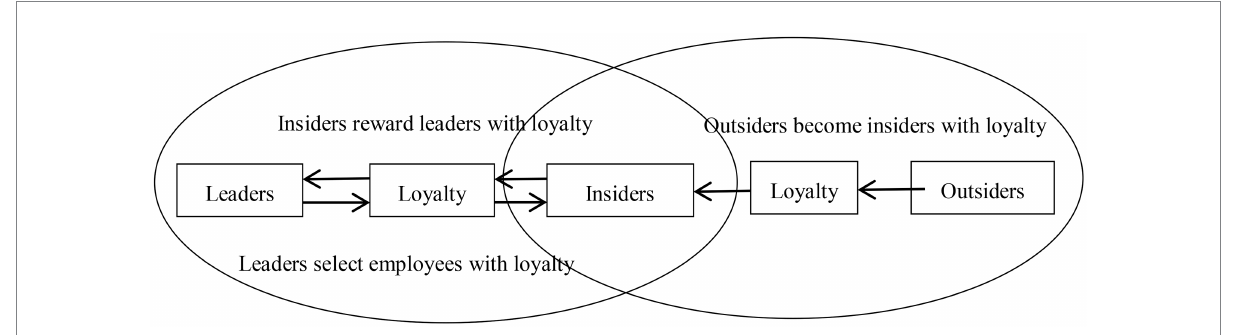
FIGURE 1 Diagram of the three-way interaction process between differential leadership, insiders and